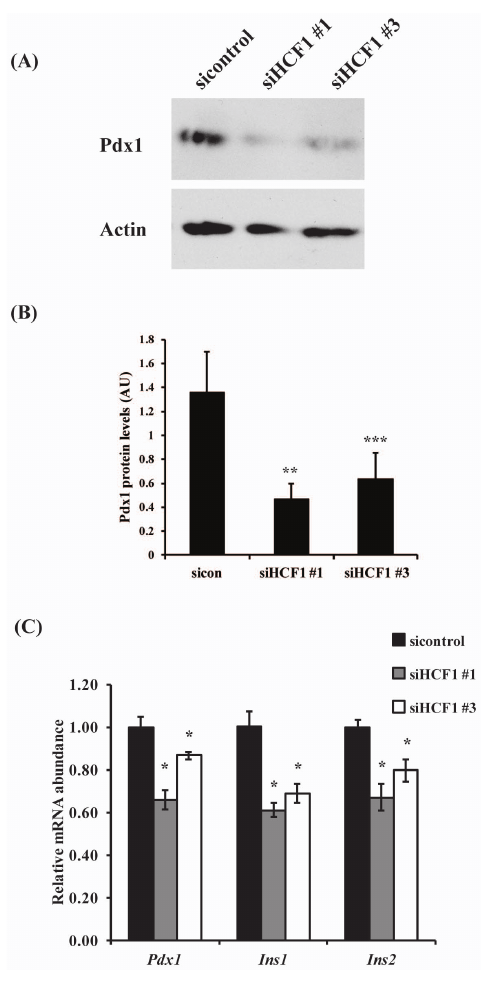
Figure 2. HCF-1 regulates expression of Pdx-1. (A) Western blot analysis of Pdx-1 protein levels in HCF-1 knockdown cells. (B) Relative Pdx1 protein levels as determined by densitometry analysis. Pdx1 levels were normalized to b -actin levels. Results are pooled from 5 experiments and represent mean + / 2 SEM. **denotes a p-value=0.03, ***denotes a p-value=0.05 (Student’s t-test). (C) RT-qPCR analysis of Pdx1 , Ins1 and Ins2 transcript levels in HCF-1 knockdown cells. The mean normalized RNA level for each gene in sicontrol treated cells was set to 1. The data shown are pooled from three independent experiments and are represented as mean + / 2 SEM. *denotes a p-value , 0.05 relative to cells treated with sicontrol siRNA (Student’s t-test).